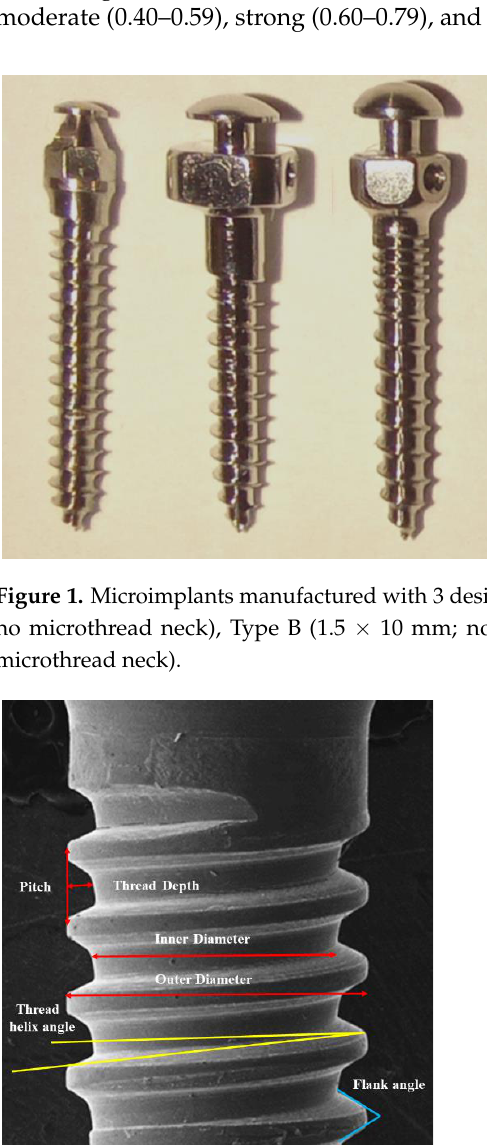
Figure 1. Microimplants manufactured with 3 designed types, from left to right: Type A. 5 × 10 mm; no microthread neck), Type B (1.5 × 10 mm; no microthread neck), and Type C (1.5 × 10 mm; micro- thread neck).